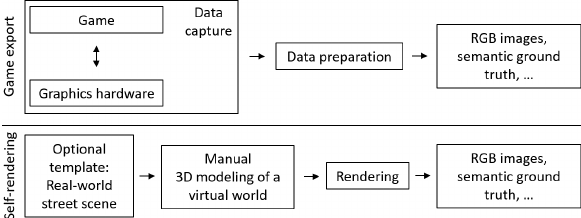
the RGB image are created. Pixels sharing the same resources are clustered to a patch automatically. The semantic ground truth image for each RGB image is created by manually annotating each patch with a semantic class. The manual effort is reduced manual annotation. The VIPER dataset provides in addition se- mantic ground truth on the so called ”instance-level”, identifying individual objects in multiple images, by exploiting information from additional